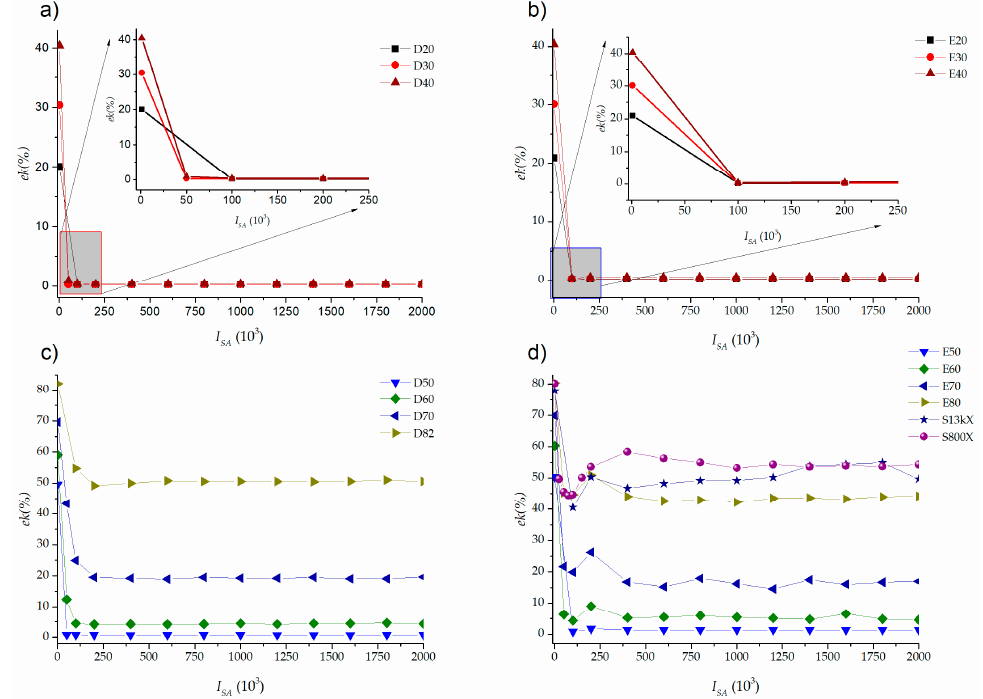
Figure 8. Average of e ffi ciency of charge ( ek )(%) for the matrix phase (j 1 ) vs. I SA ( a ) systems D20–D40; ( b ) systems E20–E40; ( c ) systems D50–D82 and ( d ) systems E20–E80 and S.